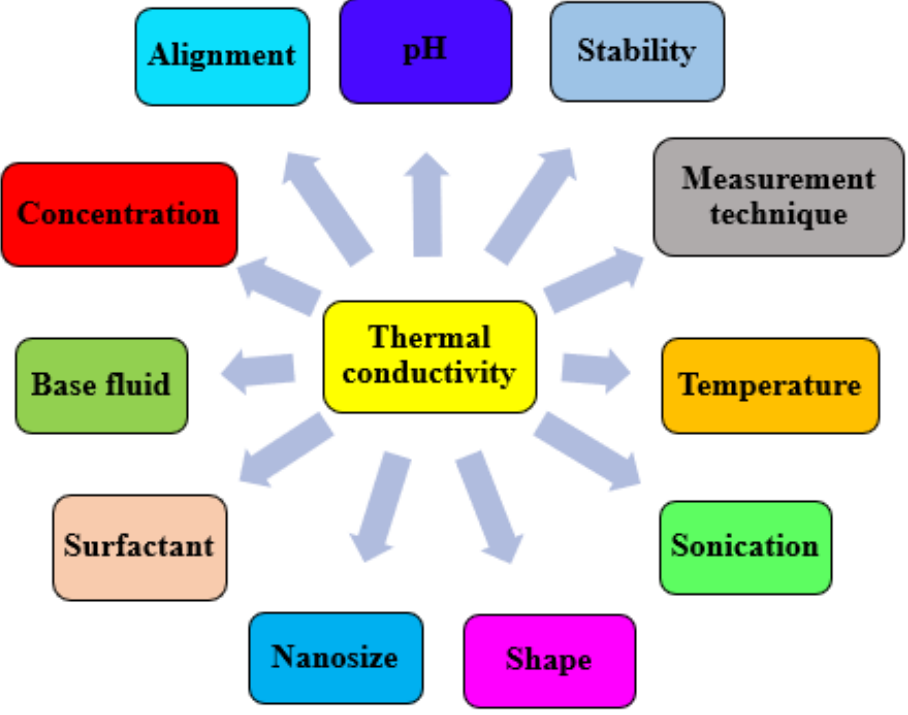
Figure 4. Factors affecting thermal conductivity of nanofluids. Under increasing volume concentration of TiO 2 /EG, the TC was observed to increase with an improvement of 18% [83]. The TC of water-based CuO and Al 2 O 3 nanofluids was found to enhance with an increase in concentration from 1 vol% to 4 vol% at room temperature [62]. Enhancements of 2–9.4% and 6.5–14% at room temperature were recorded for Al 2 O 3 and CuO nanofluids at 1 vol% and 4 vol%, respectively. The TC of Fe 3 O 4 /DIW nanofluids showed an increase as the volume concentration increased from 0.2–2 vol% with a maximum enhancement of 48% [64]. An increase in volume concentration of Fe 3 O 4 /kerosene nanofluids (0–1 vol%) was observed to directly enhance the TC [65]. The TC of MgO/glycerol nanofluid was enhanced by 19% as the volume fraction increased from 0.5% to 4% [14]. At 30 ◦ C, the TC of ZnO/EG nanofluid was enhanced by 40% when the nanofluid concentration was increased from 0.5 vol% to 3.75 vol% [84]. The TC of EG-based α Fe 2 O 3 and Fe 3 O 4 nanofluids at a volume fraction of 0.69% was observed to be augmented by 15% and 11%, respectively [85]. The TC of Al 2 O 3 /DIW nanofluids was enhanced by 15% for a weight fraction of 0.8% at room temperature [86].